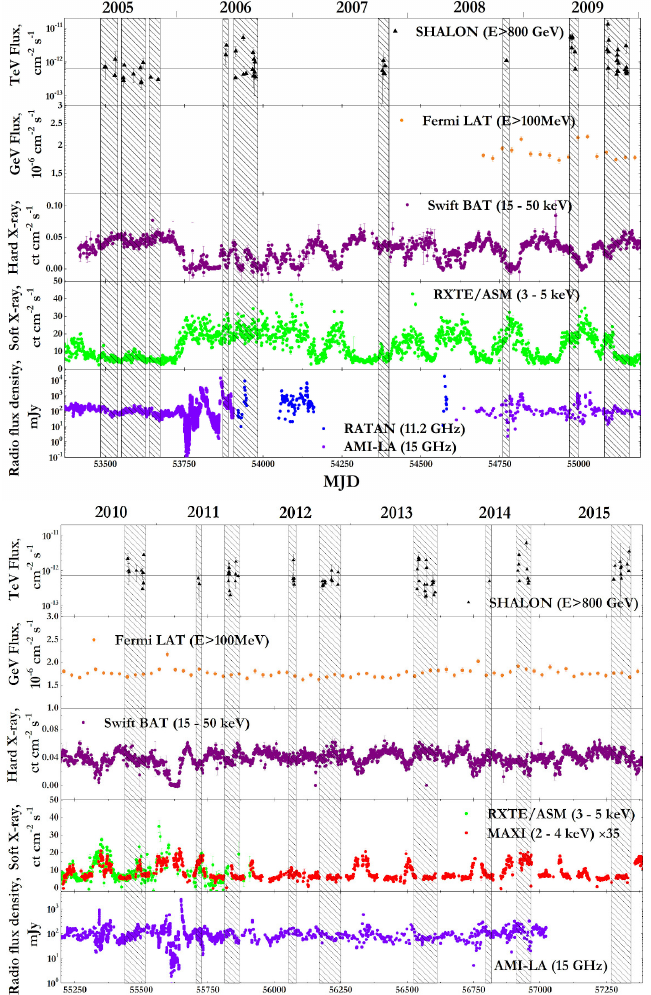
Figure 6. Light curve of Cyg X-3 in a wide energy range: radio 15 GHz (RT/AMI), 11.2 GHz (RATAN- 600), soft X rays at 3–5 keV (RXTE/ASM) and 2–4 keV (MAXI), hard X rays at 15–50 keV (Swift BAT), high energies >100 MeV (Fermi LAT), and very high energies 800 GeV–100 TeV (SHALON). The